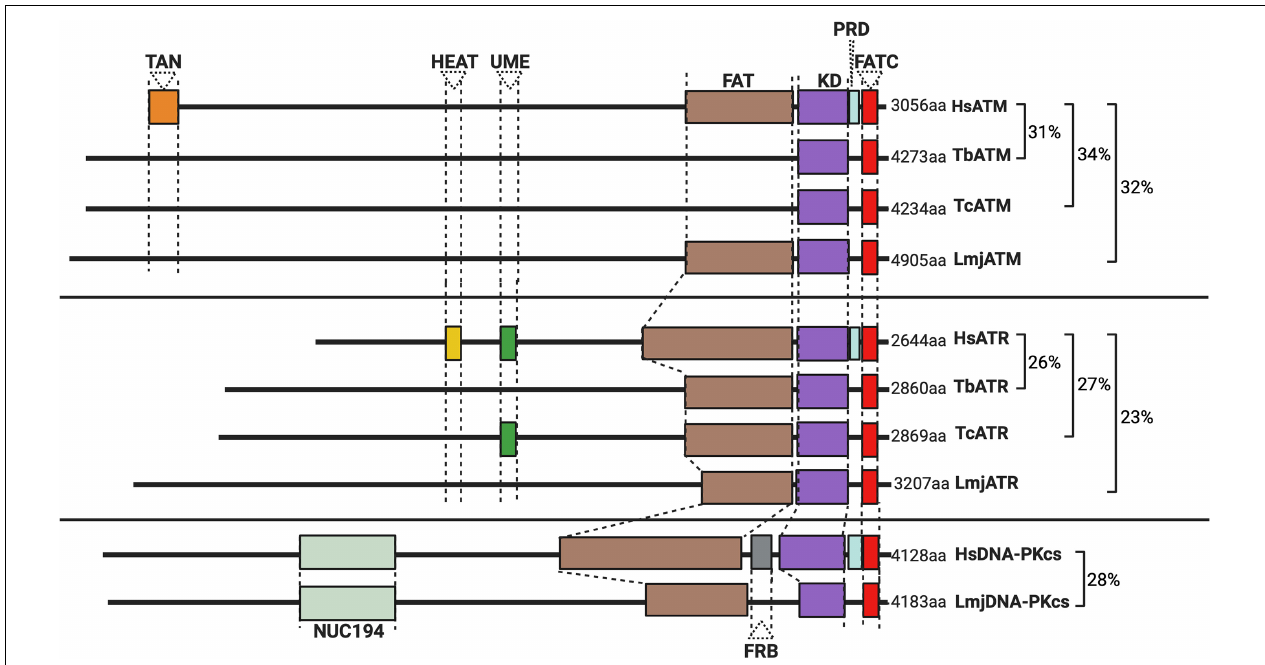
FIGURE 1 | Schematic illustration of the predicted domain locations in Trypanosomatid PIKKs compared with their human homologs. Putative domains were identified using Pfam (http://pfam.xfam.org), Prosite (https://prosite.expasy.org), and Interpro (https://www.ebi.ac.uk/interpro/). Sequence similarity was determined using BLAST (Altschul et al., 1997), and all sequences from trypanosomatids are compared to the corresponding human kinase sequence. Gene IDs, the percentage identity, and the E value for each sequence are as follows: HsATM (AAB65827.1), TbATM (TbATM427_020008900; 31.47%, 2e-99), TcATM (TcCLB.509395.20; 33.95%, 7e-108), and LmjATM (LmjF.02.0120; 31.73%, 9e-94). HsATR (NP_001175.2), TbATR (Tb427_110165100; 26.14%, 7e-119), TcATR (TcBrA4_0103840; 27.17%, 2e-199), and LmjATR (LmjF.32.1460; 23.45%, 2e-97). HsDNA-PKcs (NP_008835.5), LmjDNA-PKcs (LmjF.36.2940; 27.58%,